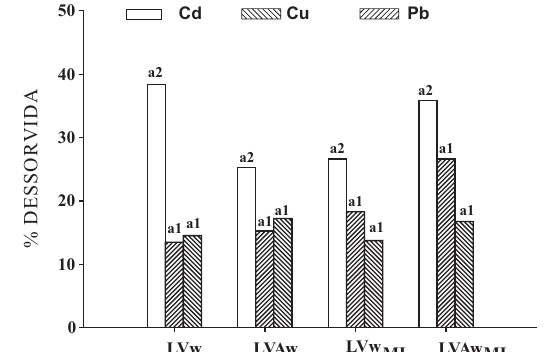
Figura 3. Dessorção porcentual de metal (M) [M /M ) x 100] de amostras de dessorvido adsorvido Latossolo Vermelho (LV) e Latossolo Vermelho- Amarelo (LVA) em solução de Ca(NO ) 3 2 5 mmol L -1 , após reação das mesmas com soluções dos metais, individualmente e simultaneamente (MI), nas concentrações de 0,10; 0,15; e 0,75 mmol L -1 . Barras seguidas de mesma letra, dentro do mesmo solo, não diferem entre si pelo teste de Scott-Knott a 5